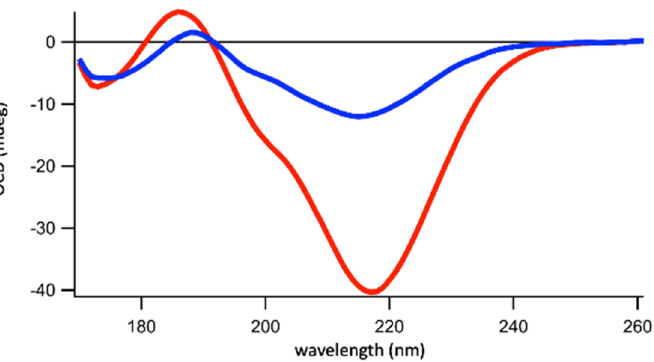
Figure 5. OCD analysis of the interaction between Hfq-CTR amyloid fibrils with EPE lipids. For the parallel alignment of a secondary structure with respect to the surface supported membrane or CaF 2 surface, the CD band has a maximum negative amplitude (red curve). If the peptide structure changes its alignment and is inserted perpendicularly to the membrane plan, the value of OCD decreases (blue curve). This confirms that the peptide is inserted perpendicular to the membrane. Note that in our conditions with a bilayer, the lipids are limiting compared to peptides and probably closer or even less than the ratio 1/10 used in this figure (blue curve). This explains why the spectrum has a minimum of around 220 nm and not 200 nm.